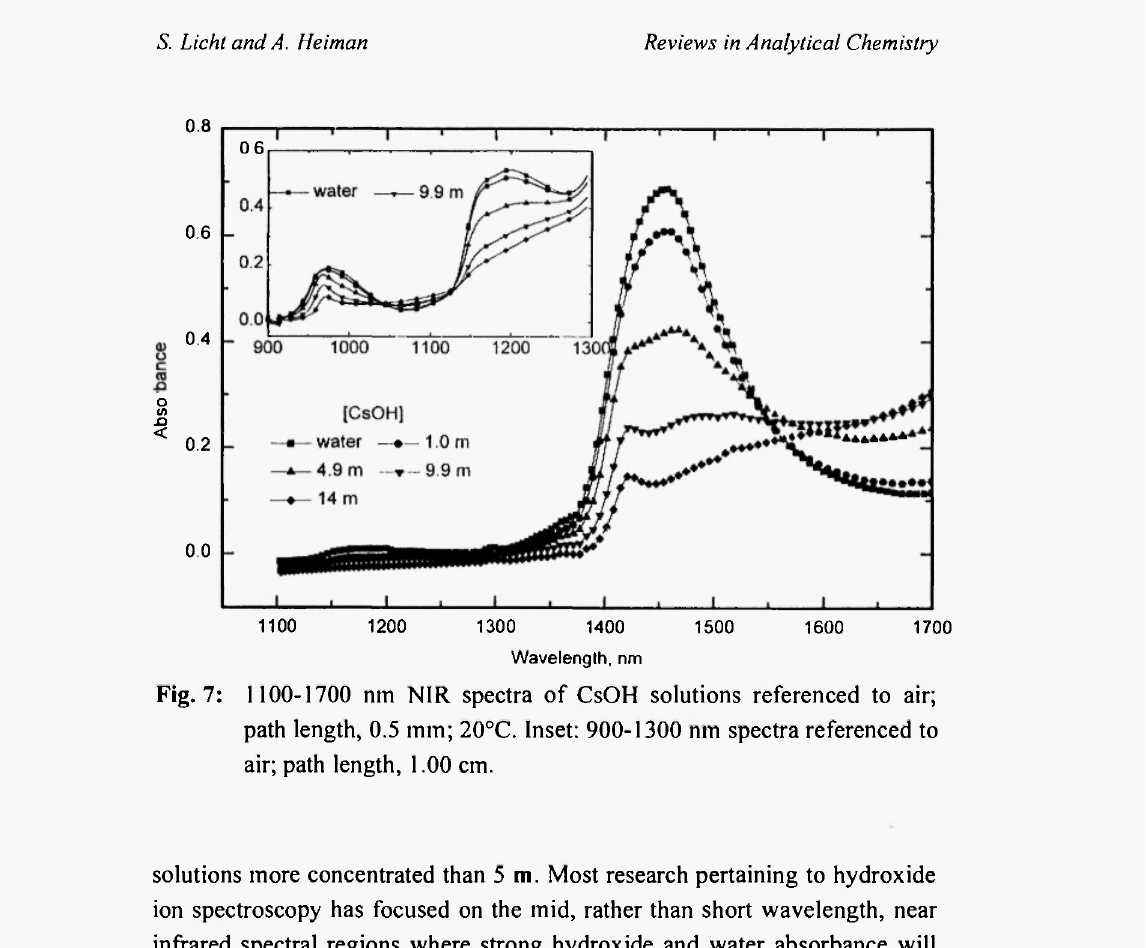
Fig. 7: 1100-1700 nm NIR spectra of CsOH solutions referenced to air; path length, 0.5 mm; 20°C. Inset: 900-1300 nm spectra referenced to air; path length, 1.00